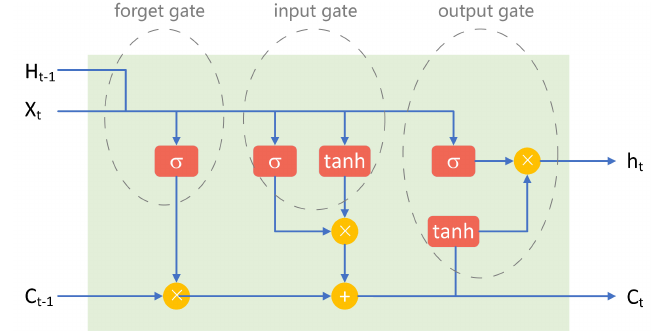
Figure 4. Structure of the repeating LSTM